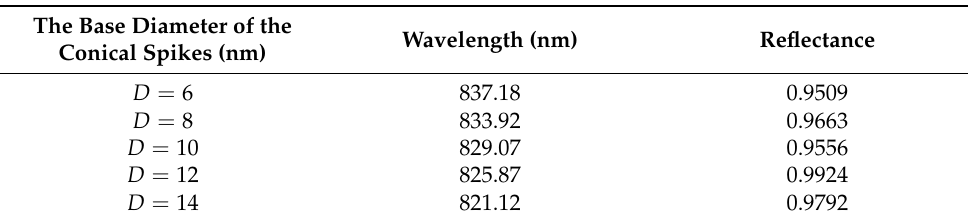
Table 3. Variations of reflectance characteristic due to the changing the base diameter of the spike proteins.